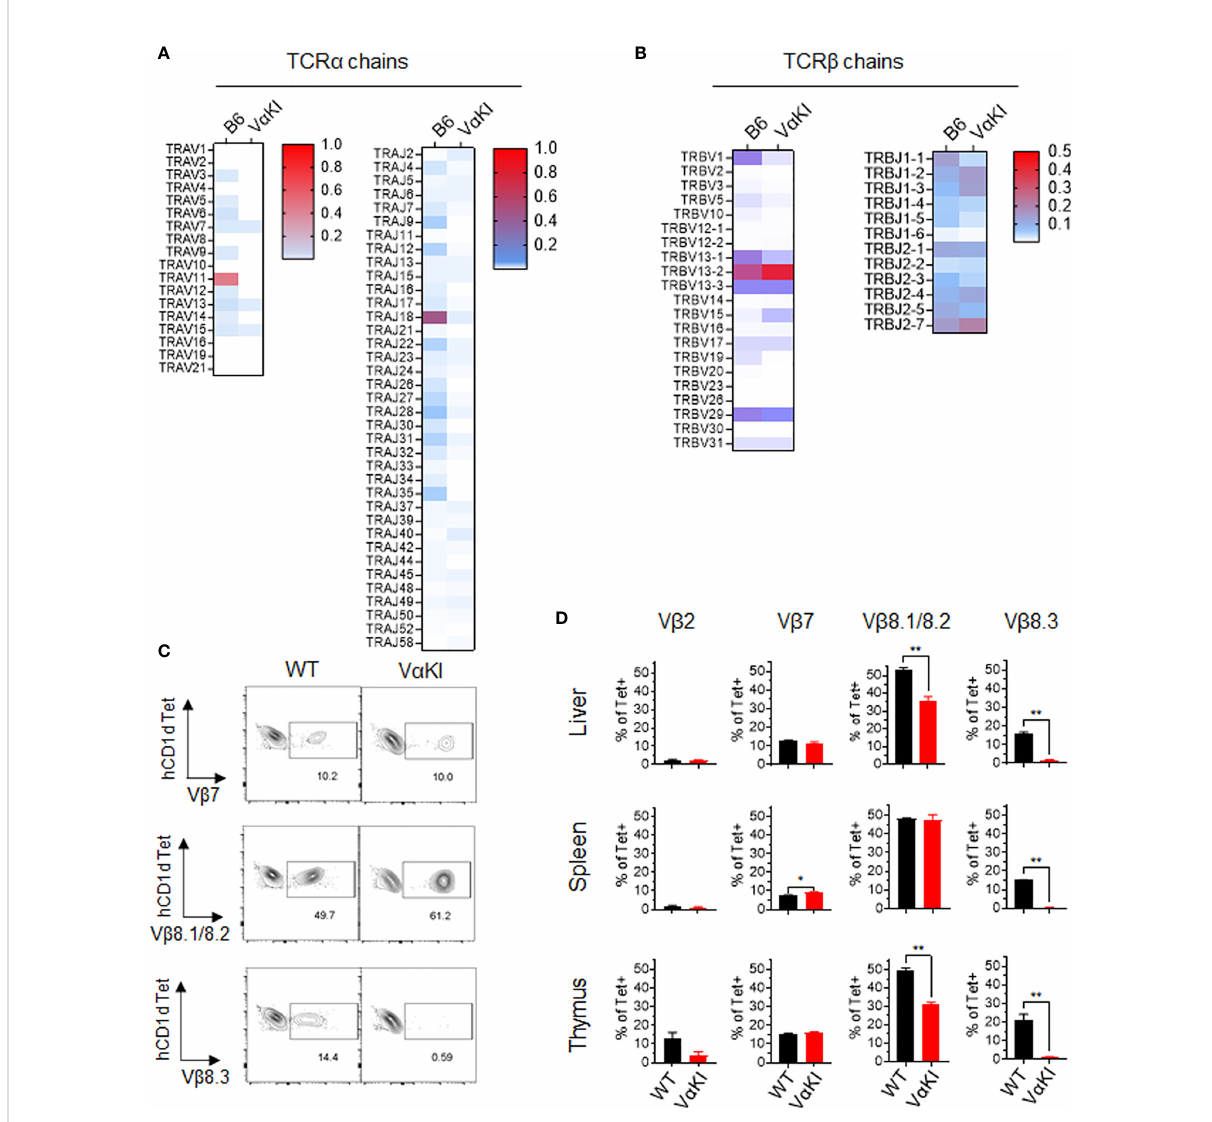
FIGURE 4 T cell receptor gene usage in CD1d tetramer binding cells from WT and V a KI mice. Sorted CD1d-Tet+ cells from WT (B6) or V a KI spleens were processed for single cell cDNA library construction, and paired TCR a and TCR b chain sequences from 4352 WT and 3186 V a KI cells were obtained. (A) Heat maps for TCR a chain V and J gene segments. (B) Heat maps for TCR b chain V and J gene segments. (C) Representative plots showing fl ow cytometry analysis of CD1d tetramer binding cells (B220 negative, TCR b + and CD1d-Tet+) in WT and V a KI mice using mAbs speci fi c for the indicated TCR V b gene products. Number indicate the percentage of tetramer+ cells staining with each anti-V b speci fi c antibody. (D) Bar graphs summarize the V b speci fi c staining on tetramer binding cells in suspensions from spleen, liver and thymus for groups of WT (C57BL/6) or V a KI mice (N = 5 for each strain). Bars show mean ± 1SE. *P < 0.05, **P < 0.01 (Mann-Whitney